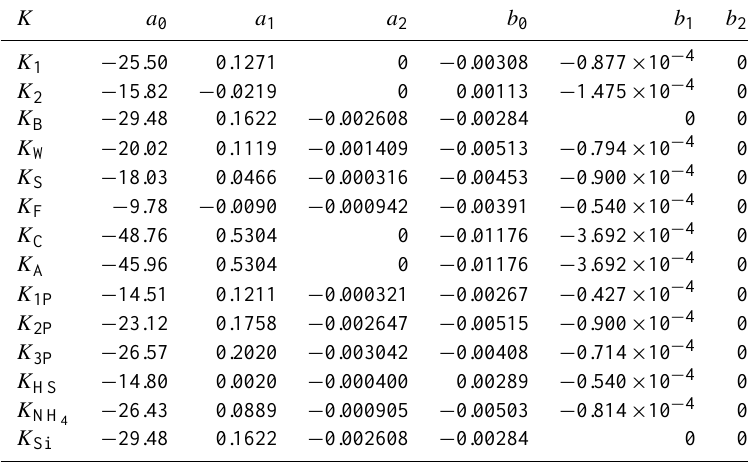
Table 7. Coefficients used in Eqs. (2) and (3) to correct for effect of pressure on equilibrium constants. K a 0